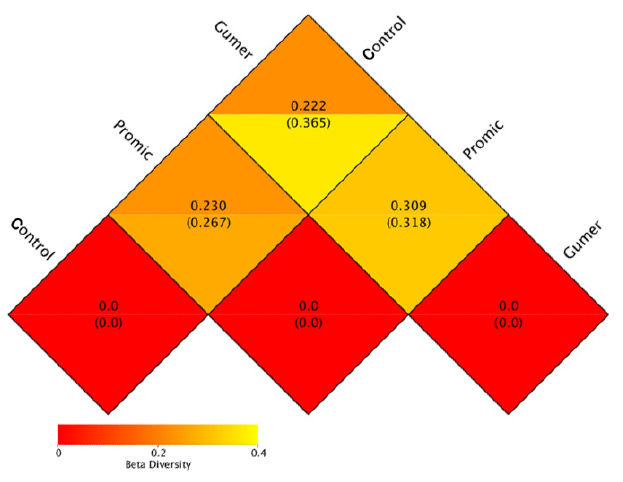
Figure 3. Heatmap based on weighted dan unweighted UniFrac distance.